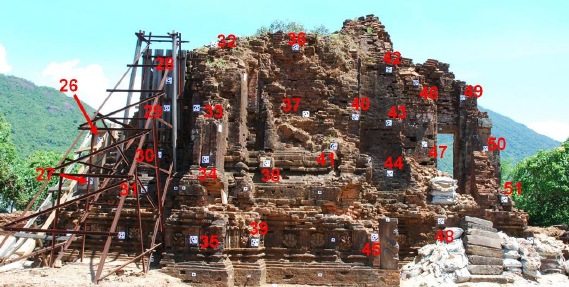
Figure 1. Myson site: Location of the 26 check points